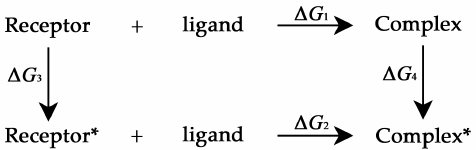
Figure 9. The thermodynamic cycle, Δ G 1 denotes the ligand-binding free energy without the introduction of the perturbation, and Δ G 2 denotes the value of the binding free energy with a residue perturbation. The receptor* and complex* represent the systems where a residue perturbation is introduced. Two nonphysical processes were constructed, i.e. , Receptor → Receptor* and Complex → Complex*. The free energy changes associated with these two constructed processes are denoted as Δ G 3 and Δ G 4 .